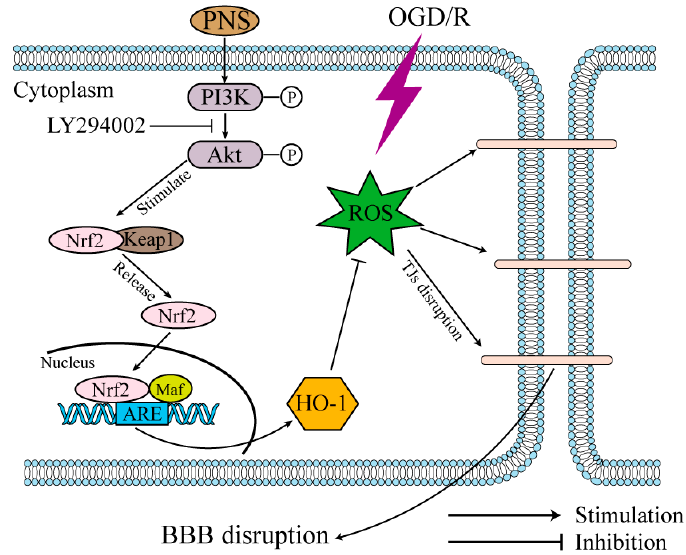
Figure 9. A proposed schematic diagram of the PNS protection on BBB endothelial cells. OGD/R induces intracellular ROS accumulation and causes oxidative stress, which leads to endothelial cell injury and BBB disruption. PNS stimulated PI3K/Akt signaling, which causes Nrf2 nuclear translocation and activation, and further enhance the downstream HO-1 expression. Finally, HO-1 prevents endothelial cells from oxidative stress-induced cell injury and BBB disruption.